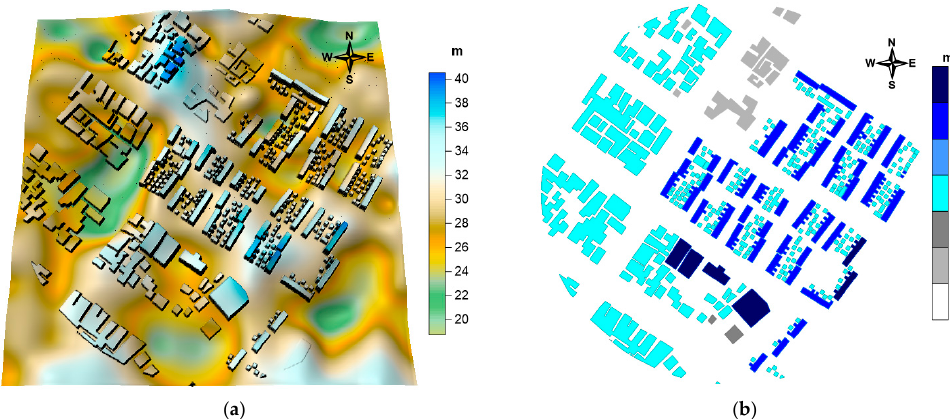
Figure 12. ( a )—Digital urban terrain model of the urban area for WAsP Engineering and WindSim models—Vertical exaggeration of 1.5×; ( b ) Buildings height.